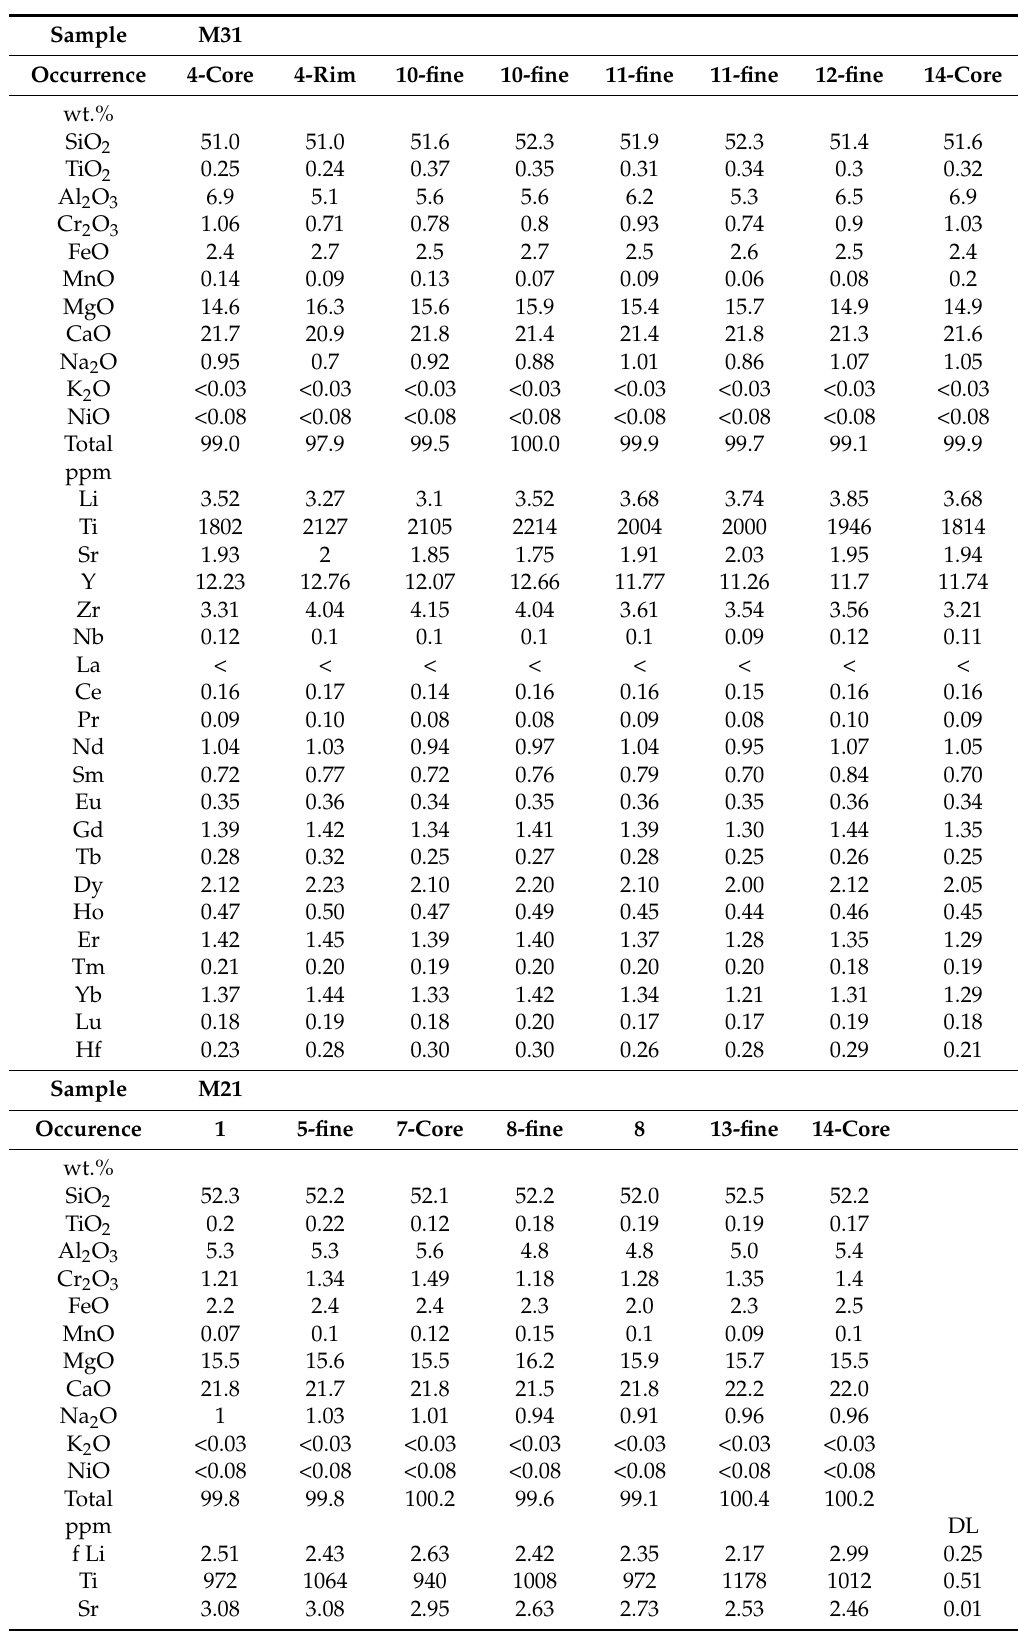
Table 3. Representative clinopyroxene